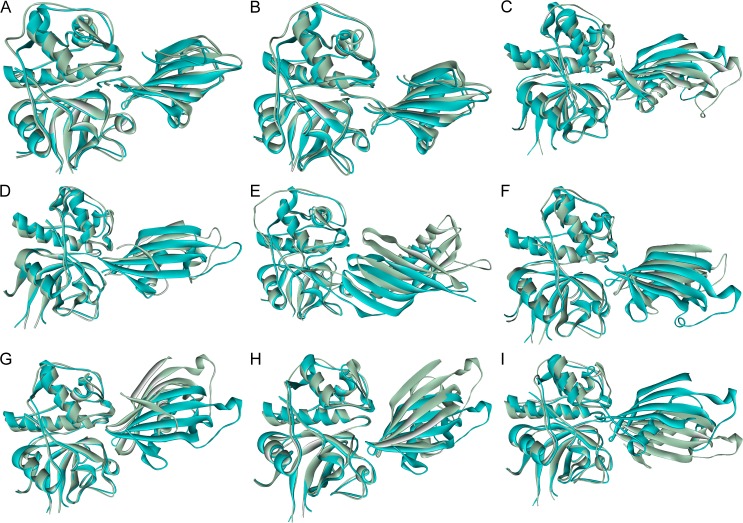
Change in conformation of complexes after refinement.Superimposed structures of refined complexes and corresponding docking outputs of cathepsin L1 complexes with (A) stefin A, (B) stefin B, (C) cystatin C, (D) cystatin D, (E) cystatin F, (F) cystatin M/E, (G) cystatin S, (H) cystatin SA, (I) cystatin SN. Refined structure was shown in green and docked output in cyan.